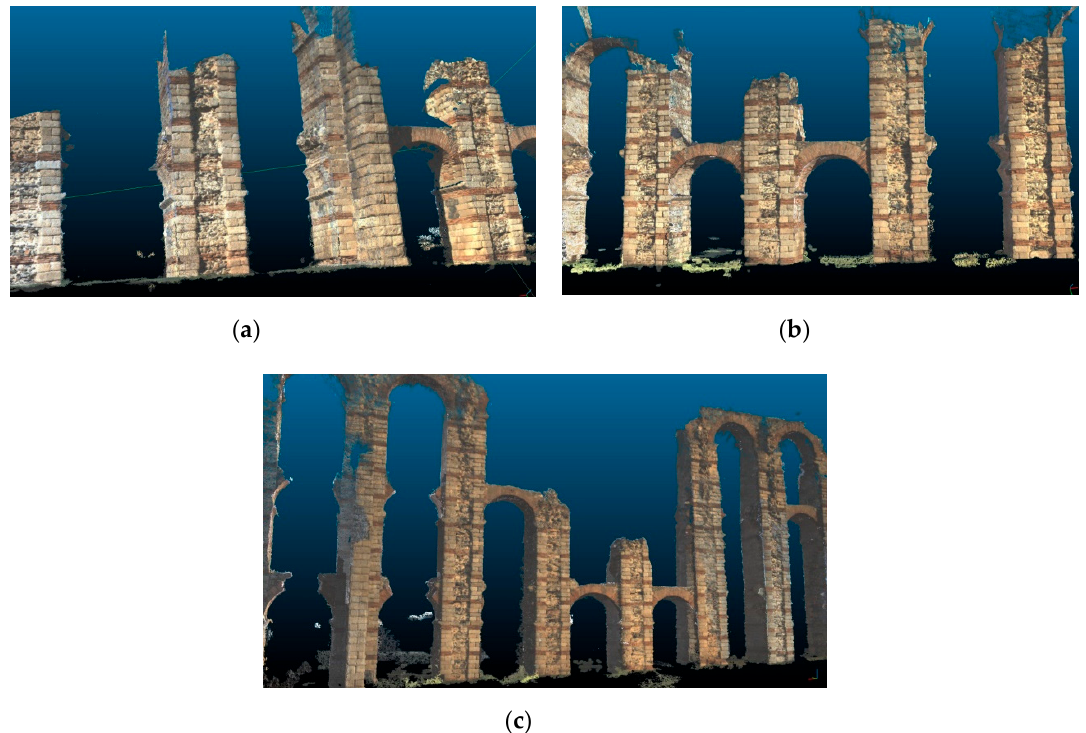
Figure 9. Points clouds resulted at the distances established in the experimental test: ( a ) 5 m; ( b ) 12 m; and ( c ) 20 m. The images show the central part of the color points clouds that resulted from the test. The points clouds have not been filtered or edited.